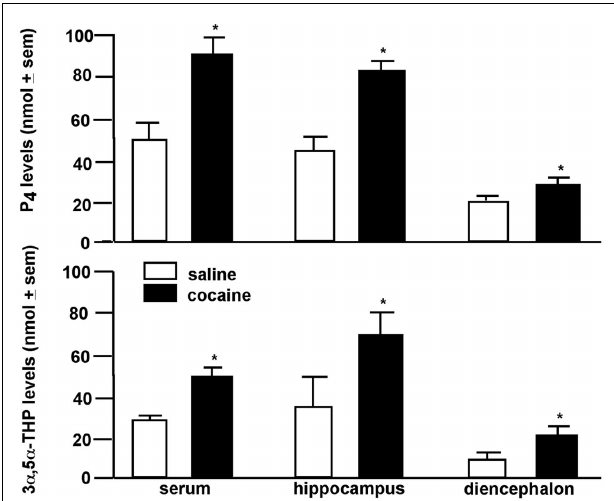
FIGURE 3 | Progesterone (P 4 ; top) and 3 α ,5 α -THP (bottom) levels are increased in serum, hippocampus, or diencephalon of female rats administered cocaine (5mg/kg, IP) compared to saline. ∗ Indicates p <